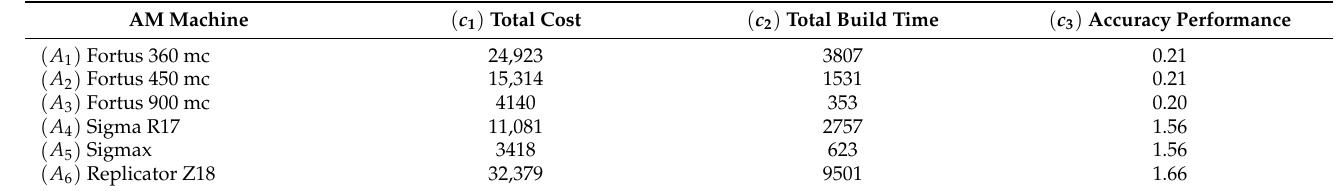
Table 9. Example 4 σ = ( 0.35, 0.4, 0.4 )